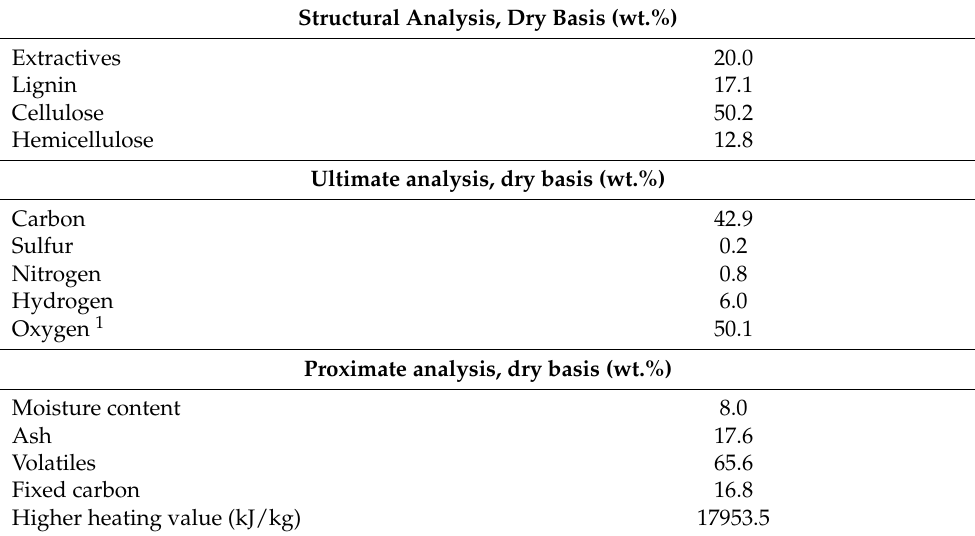
Table 1. Structural, ultimate, and proximate analysis of EFB. Structural Analysis, Dry Basis